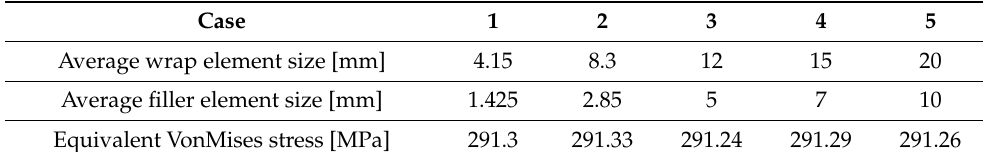
Table 3. Element quality metric.